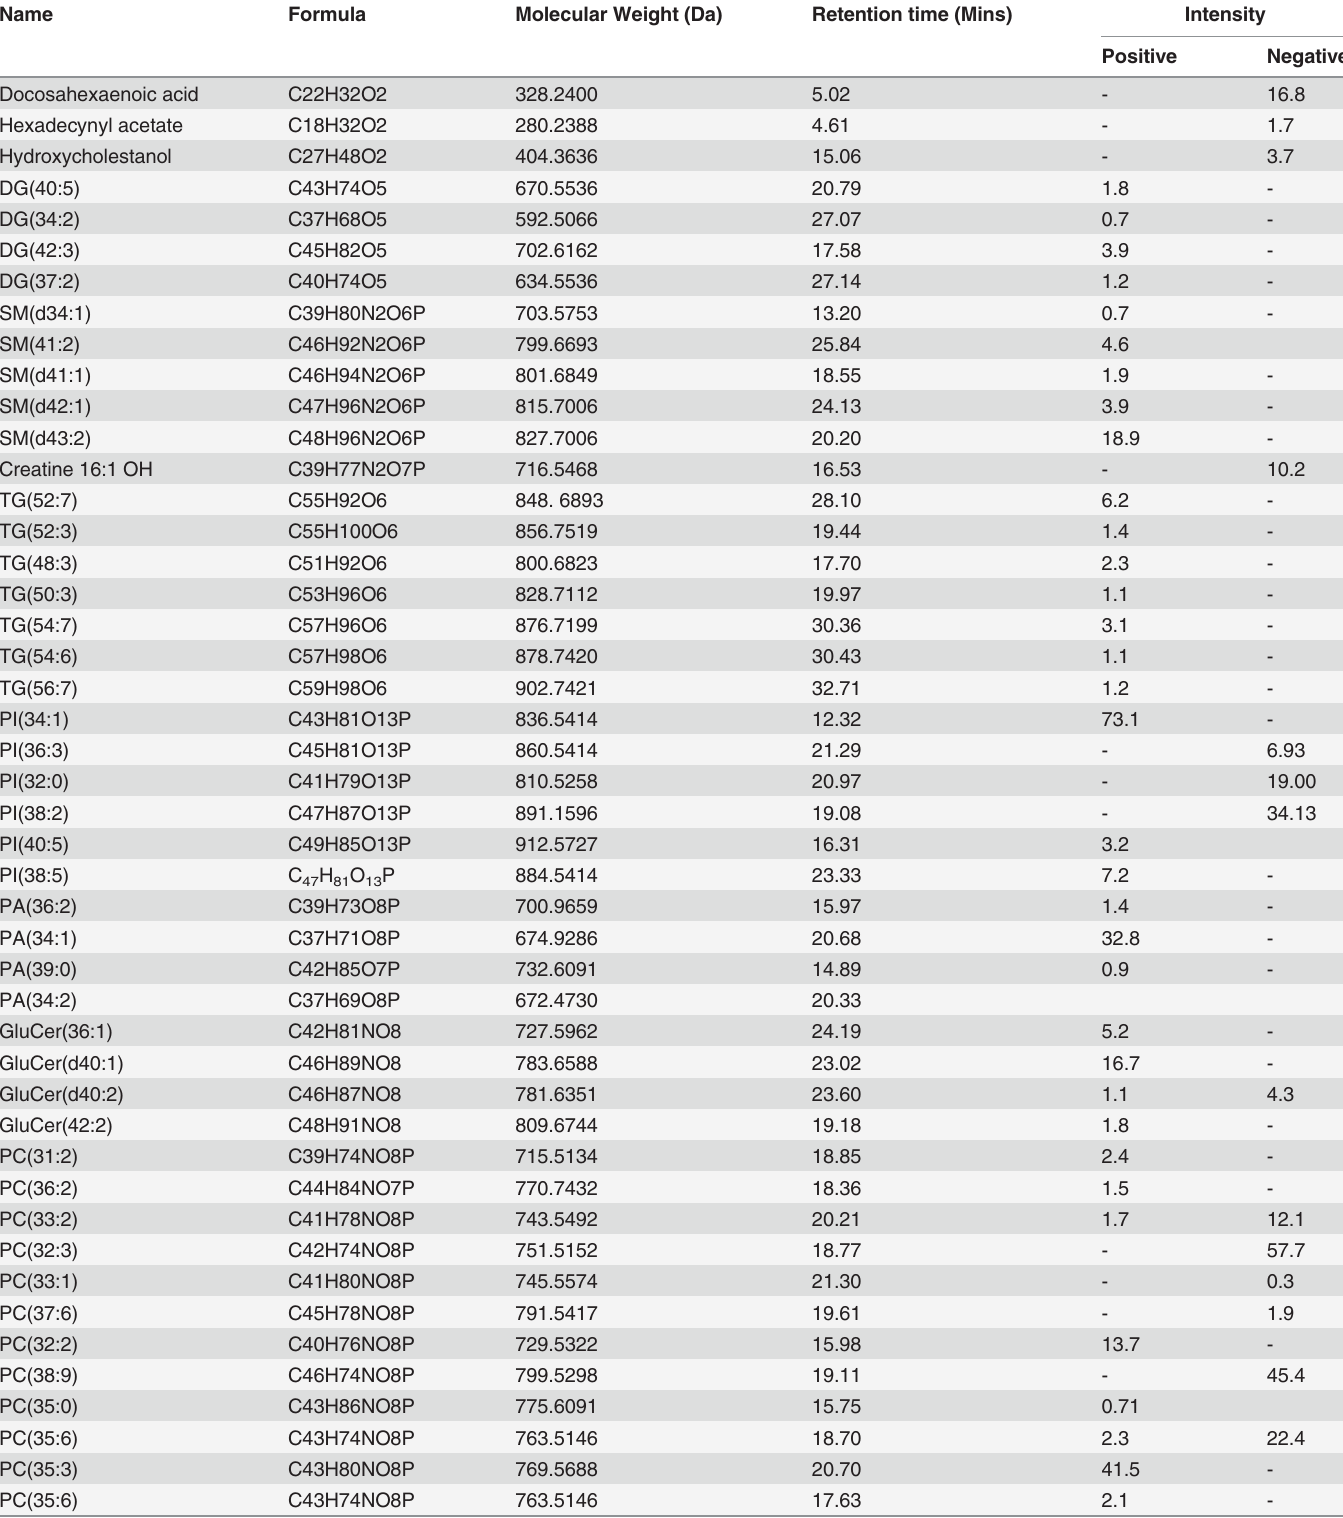
Table 6. Metabolites annotated from the reversed phase